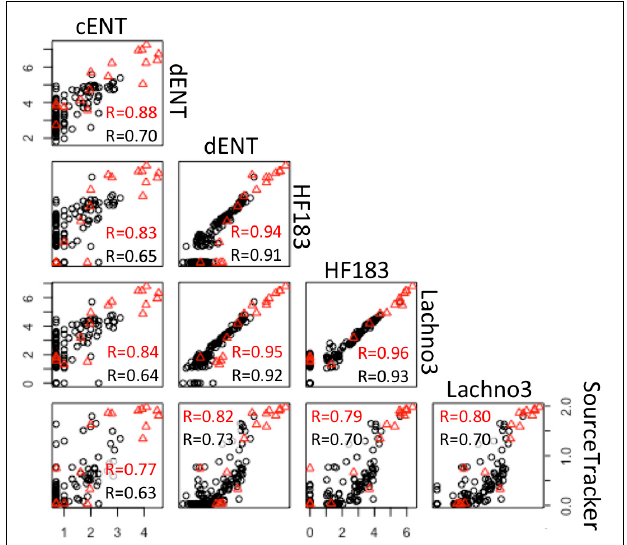
FIGURE 7 | Correlations between log-normalized microbial indicator (enterococci by culture and ddPCR and human markers, HF183 and Lachno3) results and log-normalized (x + 1) SADB WTP contributions estimated by SourceTracker. Red r -values refer to correlations between data collected at all sites. Black r -values refer to correlations between environmental beach sites only (with the SADB WTP outfall and mixing zone excluded).